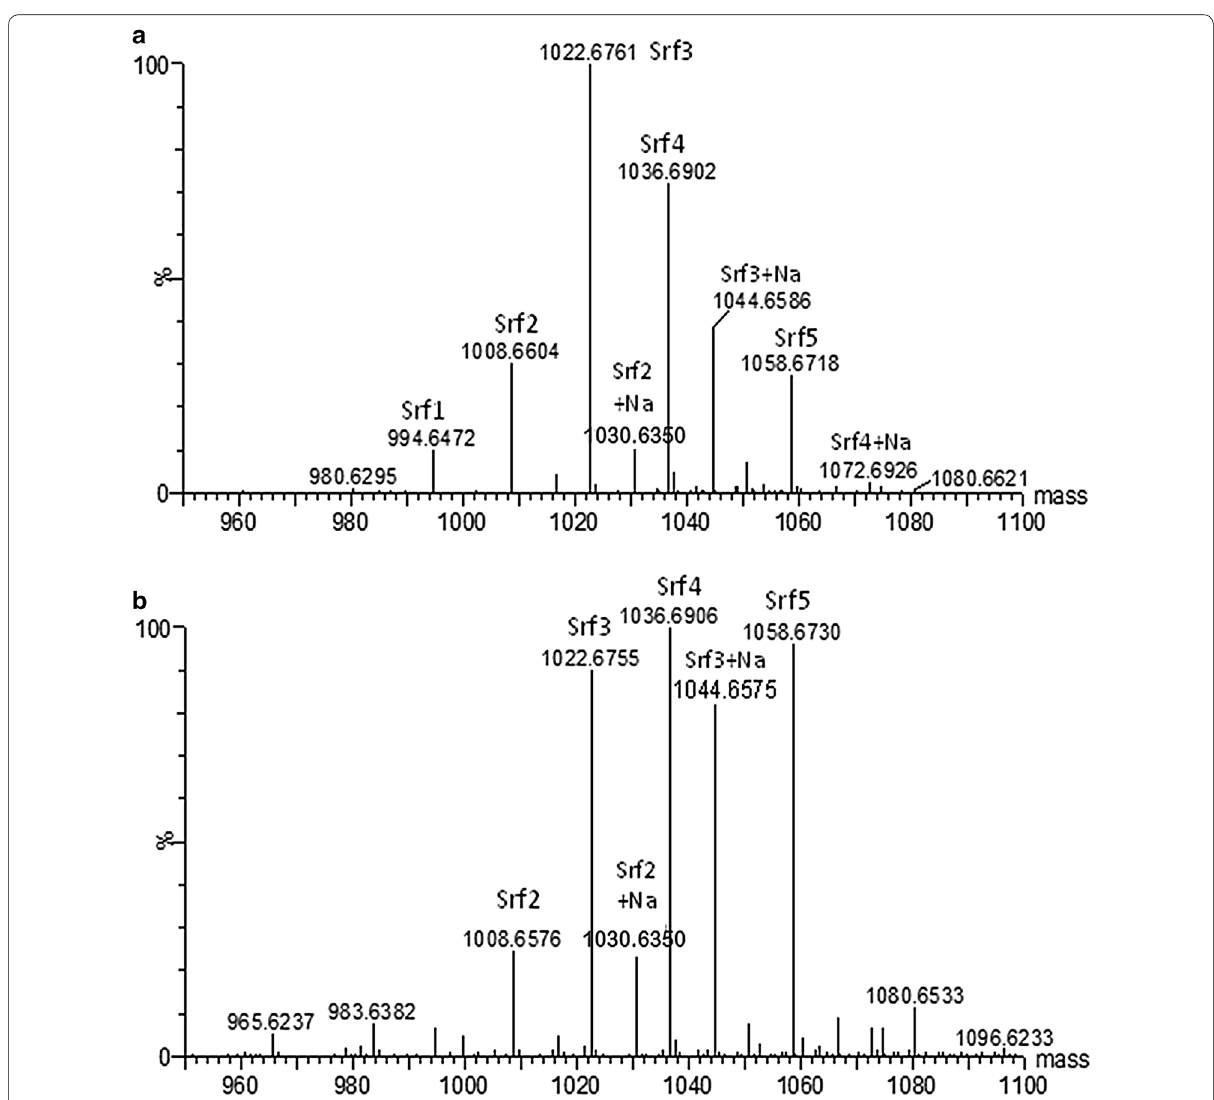
Fig. 1 ESI–MS analysis of the ST34 glycerol-MSM extract ( a ) and surfactin standard ( b ). The positive mass spectrum generated with MaxEnt 3 is shown. The indicated masses are [ M r